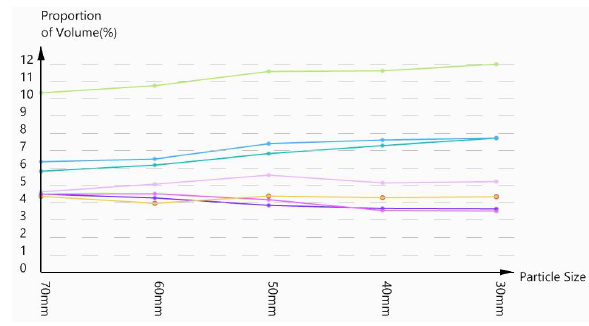
Figure 7. Rainfall Events Testing Result For Test Site 1